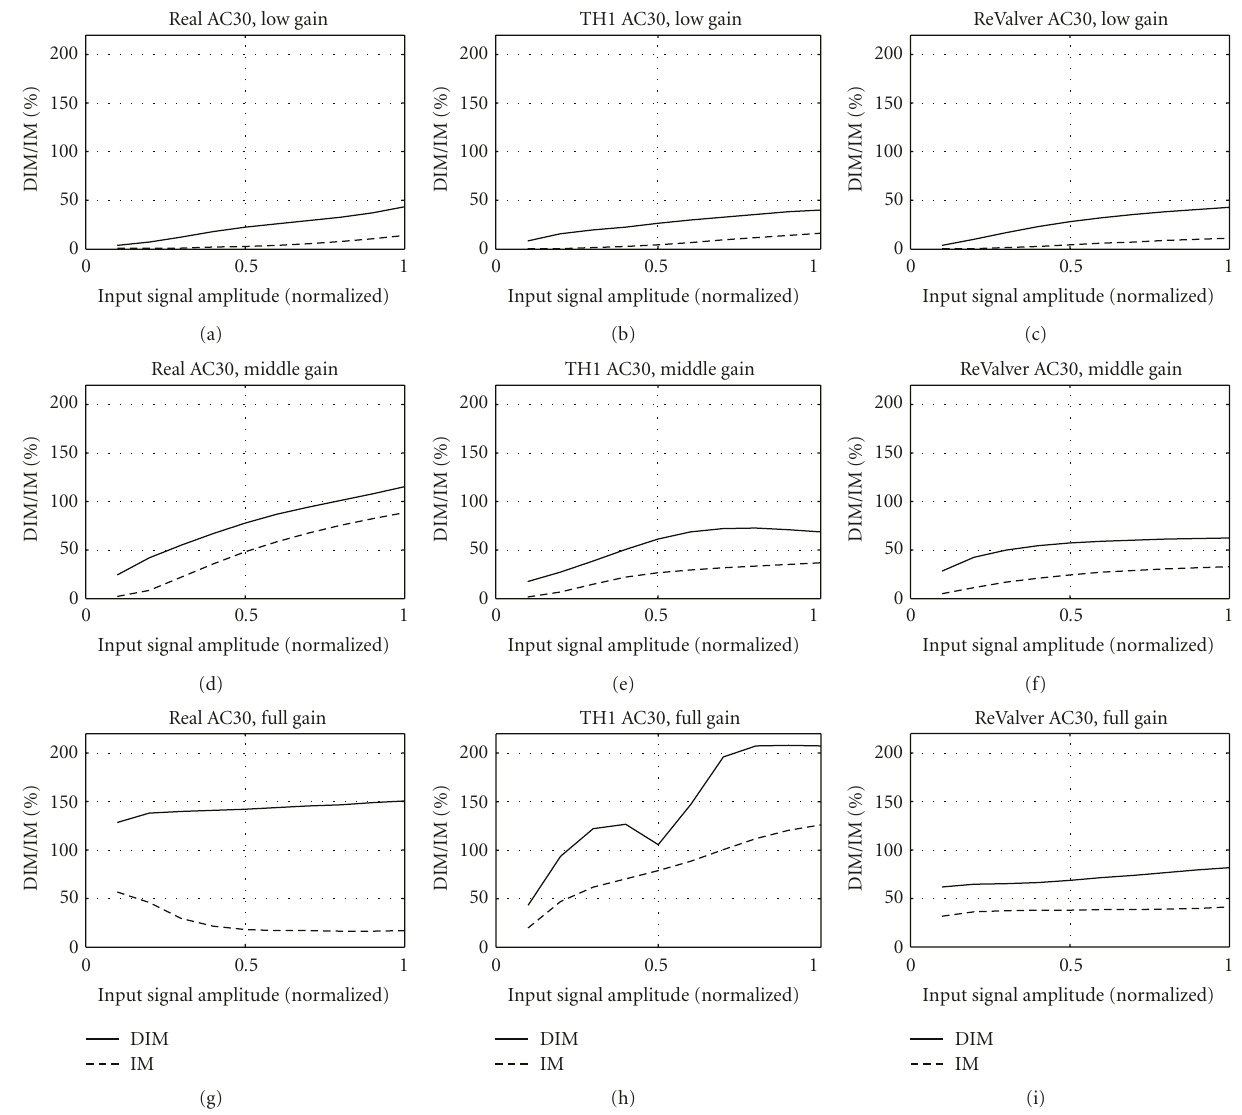
Figure 8: Intermodulation distortion analysis of the real AC30 (left column), the TH1 AC30 (middle column), and the ReValver AC30 (right column). The gain knob was first set to 9 o’clock (top row), then to 12 o’clock (middle row), and finally to full (bottom row). The solid line illustrates the amount of dynamic intermodulation distortion, while the dashed line denotes the amount of static intermodulation distortion, both as a function of the normalized input signal